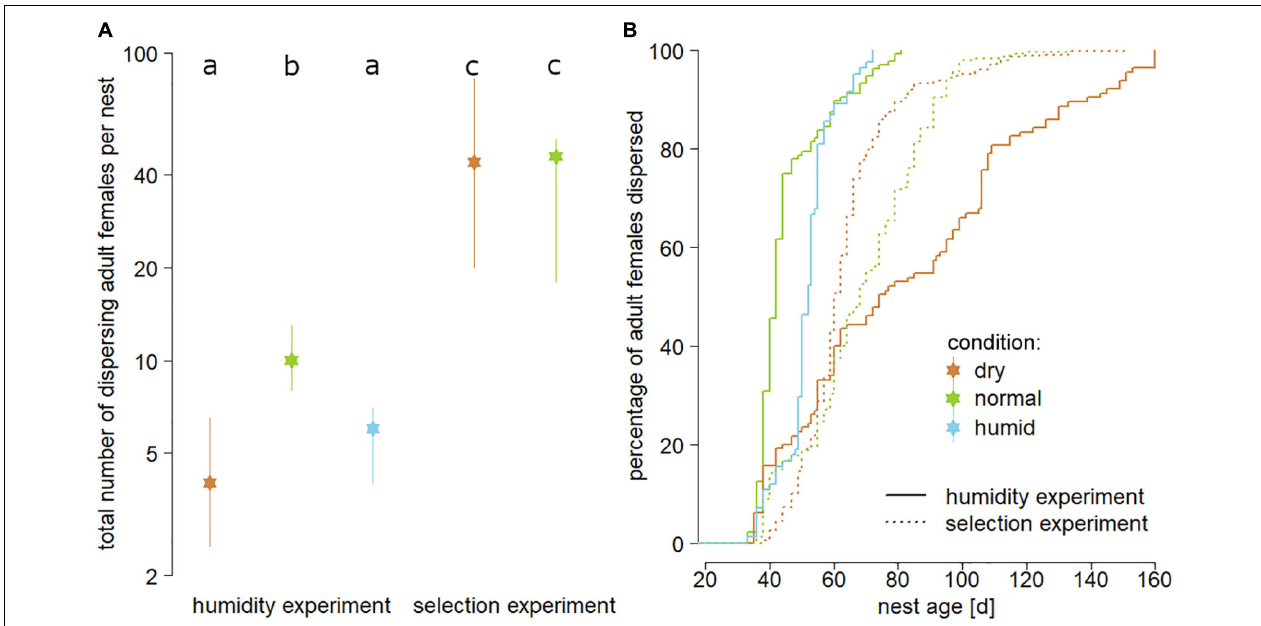
FIGURE 2 | Panel (A) illustrates the overall fitness impact of the three tested substrate humidities, indicated by medians and interquartile ranges of the total number of dispersing females per nest (logarithmic scale; “dry” = brown, “normal” = green, “humid” = blue). Different lower-case letters in the top line indicate statistically significant differences ( t -tests corrected for multiple testing; P < 0.05). Panel (B) shows differences in the length of dispersal delay of adult females for both experiments and all treatments. Solid lines represent first generation nests of the humidity experiment , whereas dotted lines represent nests that had been reared for a final test in either “dry” (brown) or “normal” (green) substrate after the beetles had been reared in dry substrate for five generations ( selection experiment